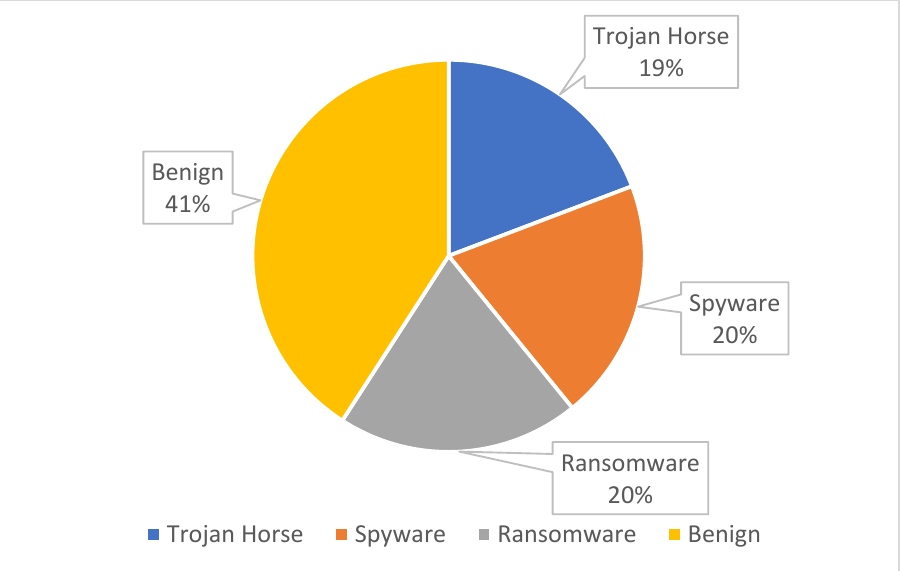
Figure 1. The Memory Dump Dataset Structure.